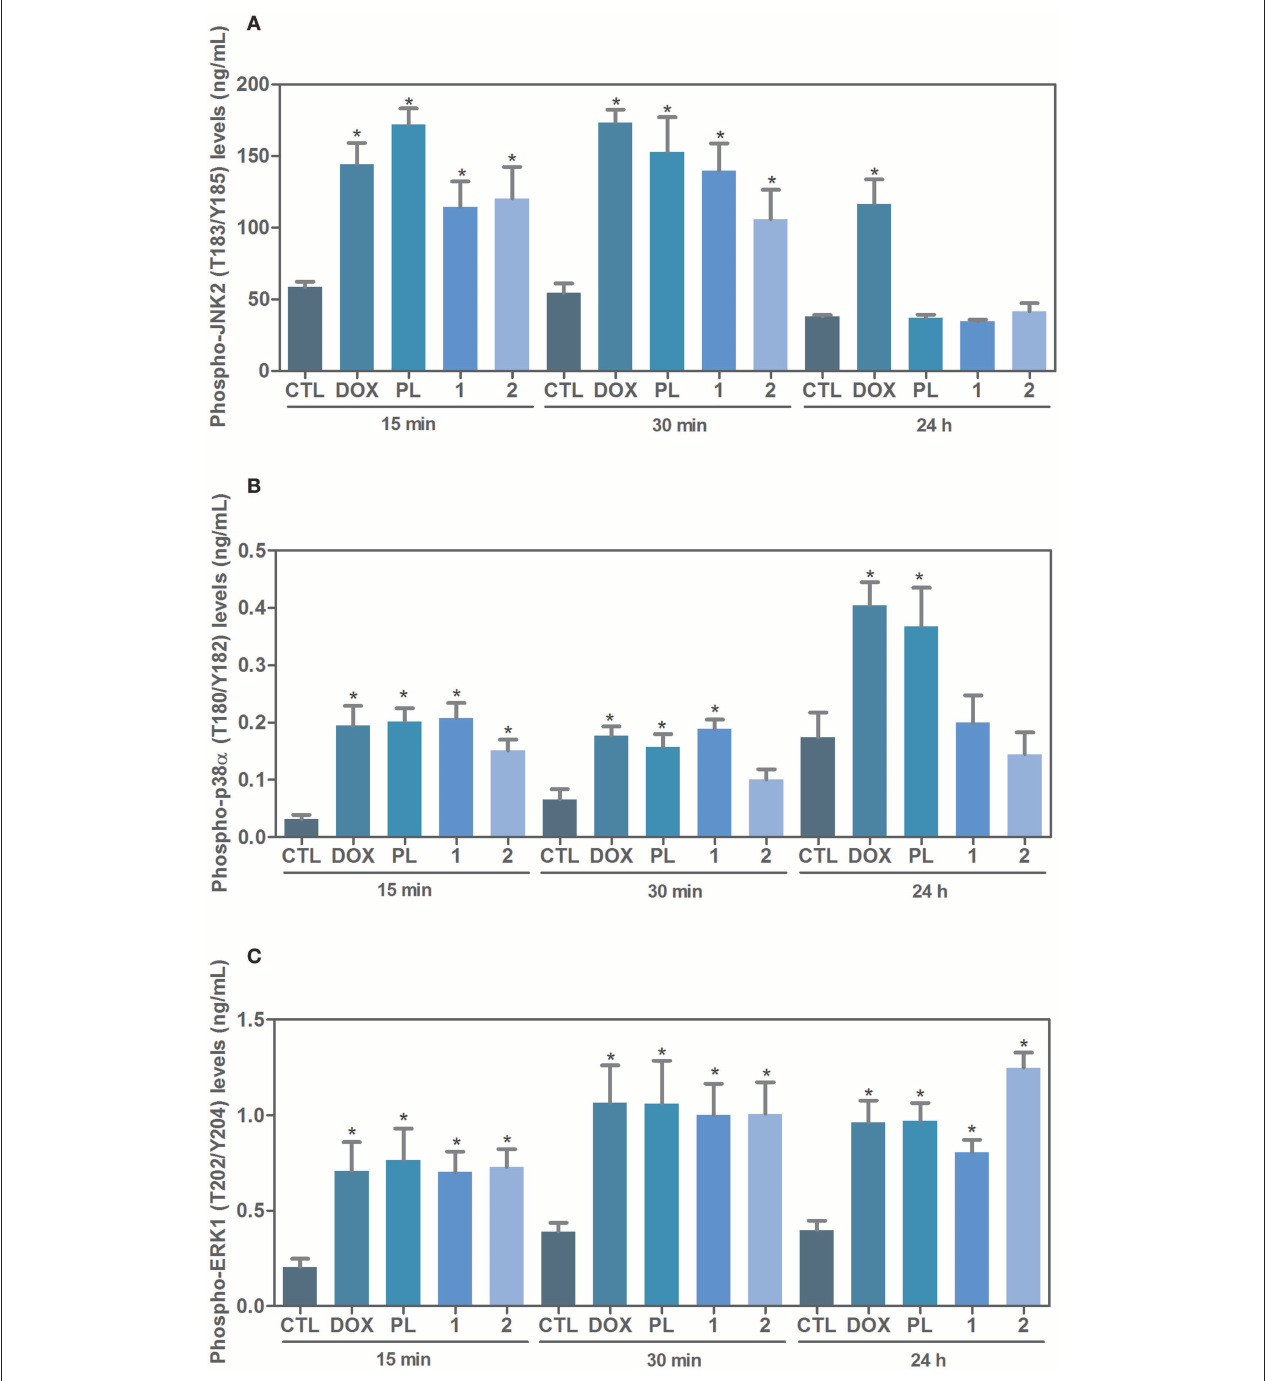
FIGURE 3 | Effect of ruthenium complexes with piplartine in phospho-JNK2 (T183/Y185), phospho-p38a (T180/Y182), and phospho-ERK1 (T202/Y204) levels, as determined by phospho-specific ELISA in HCT116 cells treated with ruthenium complexes at established concentration (2.5 µ M for complex 1 and 5 µ M for complex 2 ) for an acute (15 or 30min) or prolonged (24h) incubation. (A) Quantification of phospho-JNK2 (T183/Y185) levels. (B) Quantification of phospho-p38 α (T180/Y182) levels. (C) Quantification of phospho-ERK1 (T202/Y204) levels. Negative control was treated with the vehicle (0.1% of a solution containing 70% sorbitol, 25% tween 80 and 5% water) used for diluting the complexes tested. Doxorubicin (1 µ M) and piplartine (10 µ M) were used as positive controls. Data are presented as mean ± S.E.M. of three independent experiments performed in duplicate. * P < 0.05 compared with negative control by ANOVA, followed by Student-Newman-Keuls test.